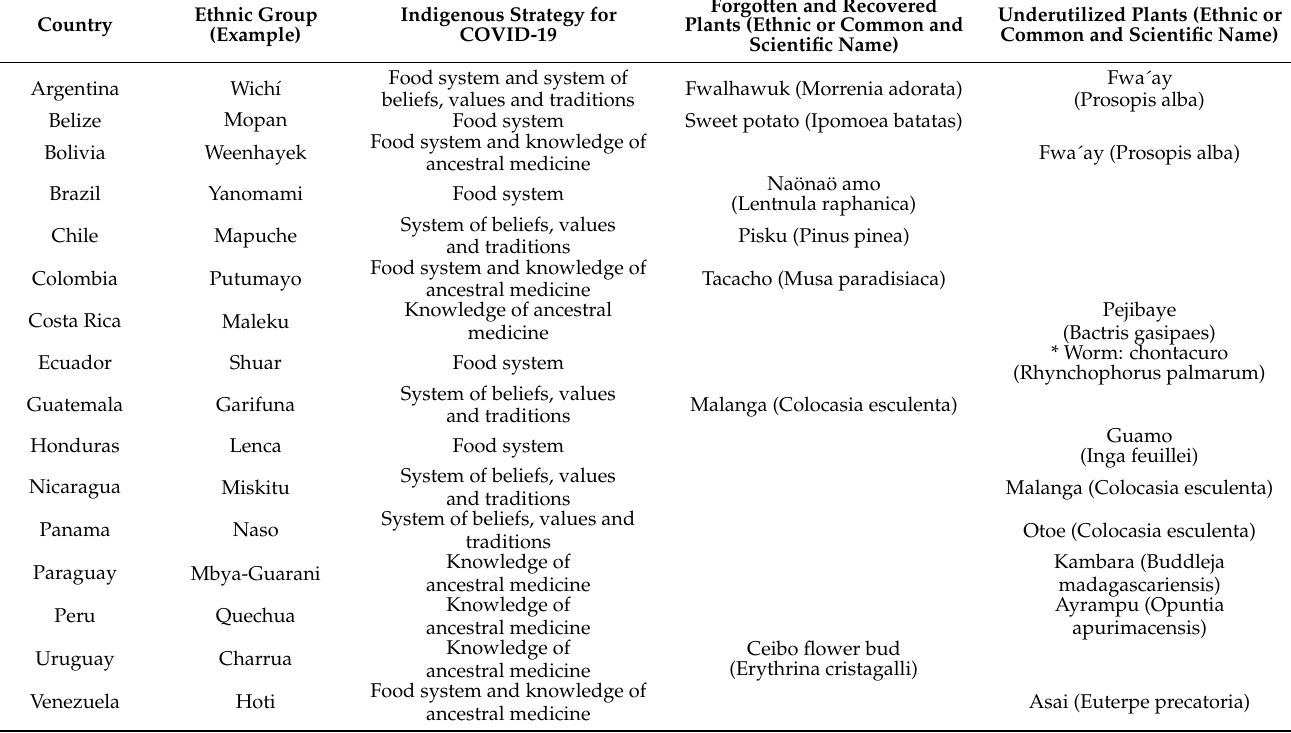
Table 1. Ethnic groups in Central and South America and the use of some wild and cultivated edible plants. The food systems of these indigenous groups have historically used edible plants and insects in their diet, their intensity of use has changed due to cultural, environmental, or economic elements, but they have never ceased to be part of the indigenous food